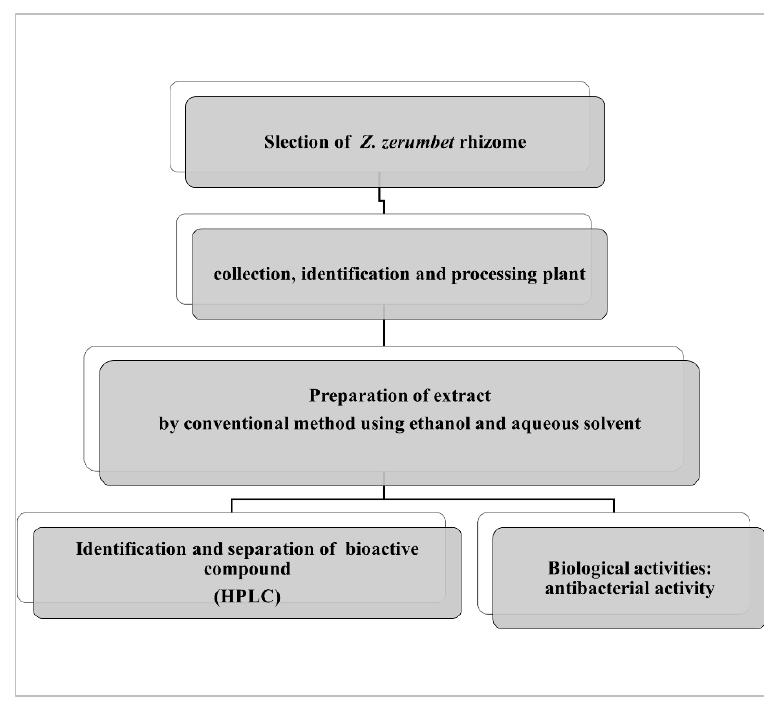
Figure 1. General flow chart of the plant extraction and biological activity. Figure 3. General flow chart of the plant extraction and biological